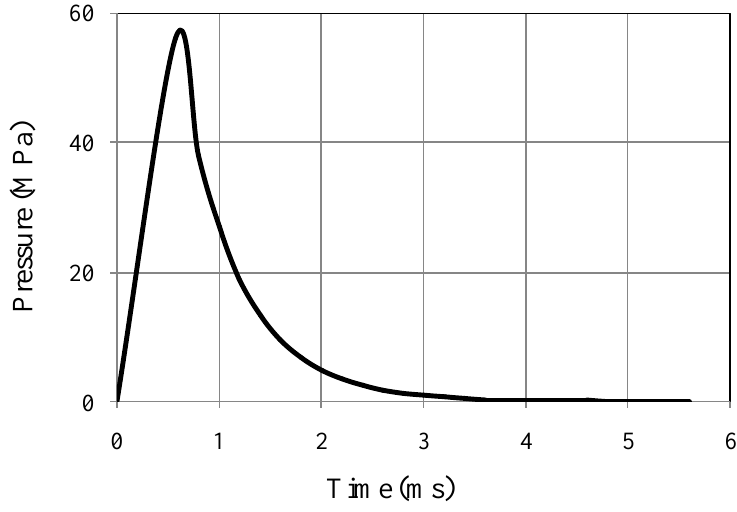
Fig. 3. Variation of induced pressure from blast loading in the camouflet with time